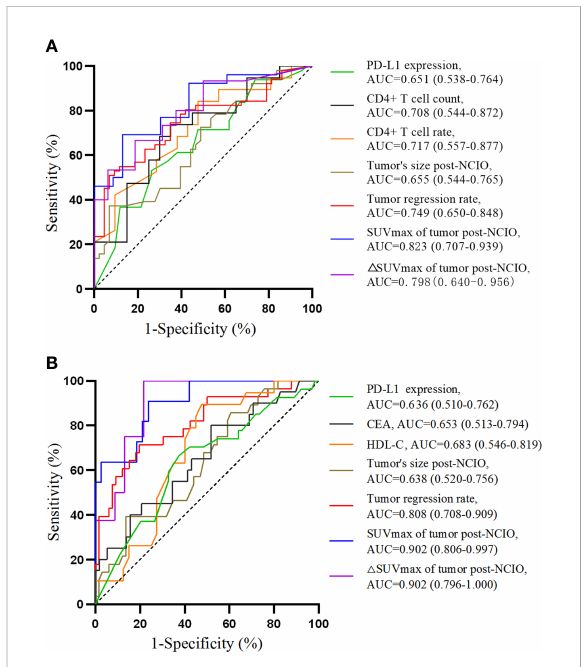
FIGURE 2 Receiver operating characteristic curves of univariate analyses. (A) For pathological complete response; (B) for major pathologic response. AUC, area under